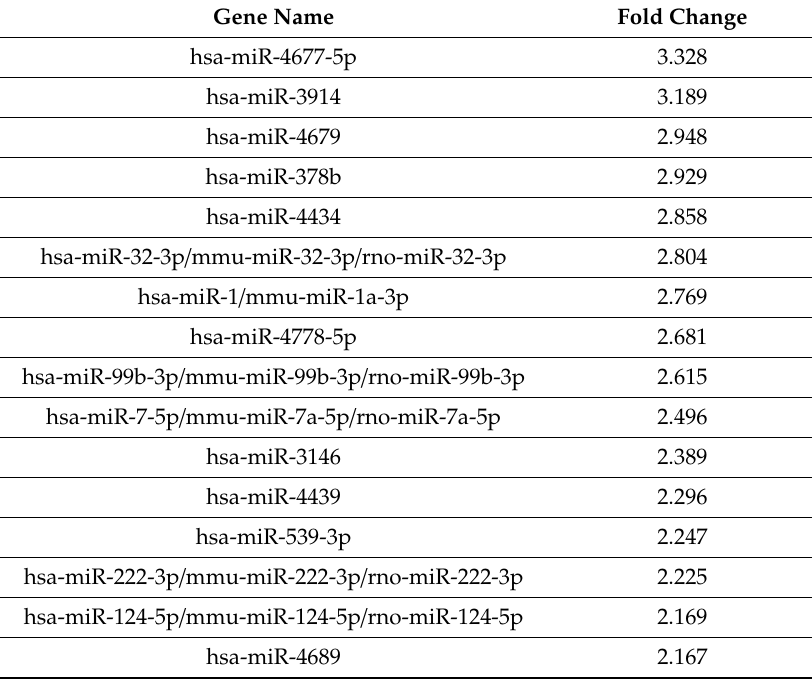
Figure 7. Scatter plot ( a ) and volcano plot ( b ) analyses reporting the alteration of miRNA profile as related to BR at the level of implants with high plaque index (PI). Table 4. miRNA that were found to be “protective” from bone resorption despite the presence of plaque deposits (high PI) and their fold variation. The fold change indicates the ratio of miRNA expression intensity between the two categories of implants stratified according to differences in bone resorption (increased vs. normal) next to implants with high PI.